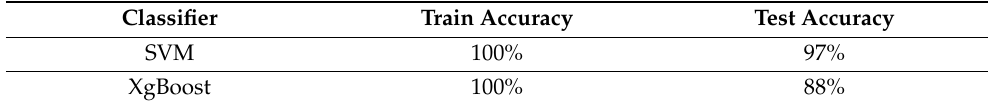
Table 4. Model Accuracy by Classifiers.